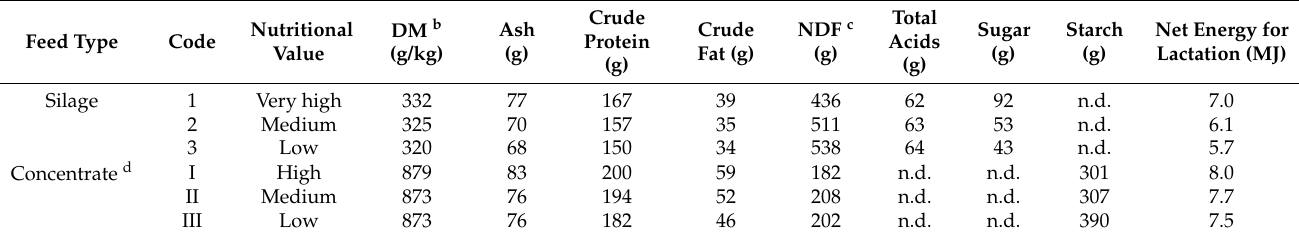
Table 3. Chemical composition (per kg of dry matter) of silages and concentrates in the NorFor a -database used for the operational